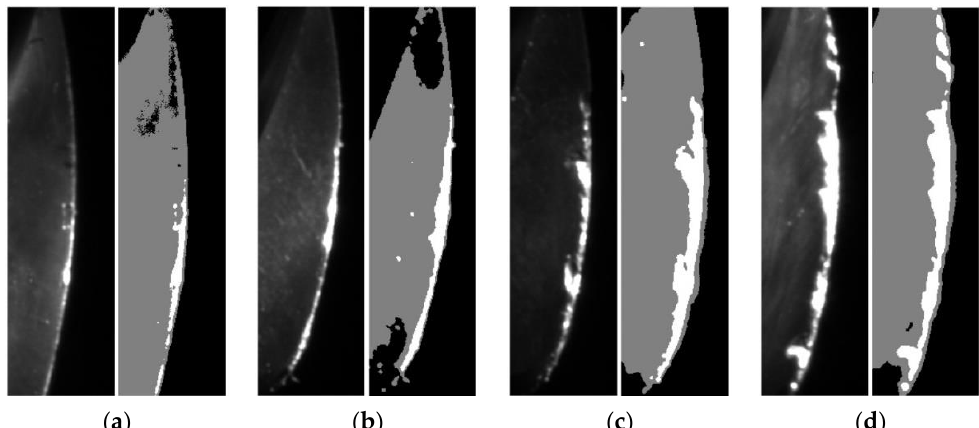
Figure 11. Rake face status at different time during machining: ( a ) t = 4 h; ( b ) t = 7 h; ( c ) t = 10 h; ( d ) t = 12 h. The original unprocessed images and processed images with extracted failure regions of the rake face are shown in the left and right parts of the subfigures, respectively.